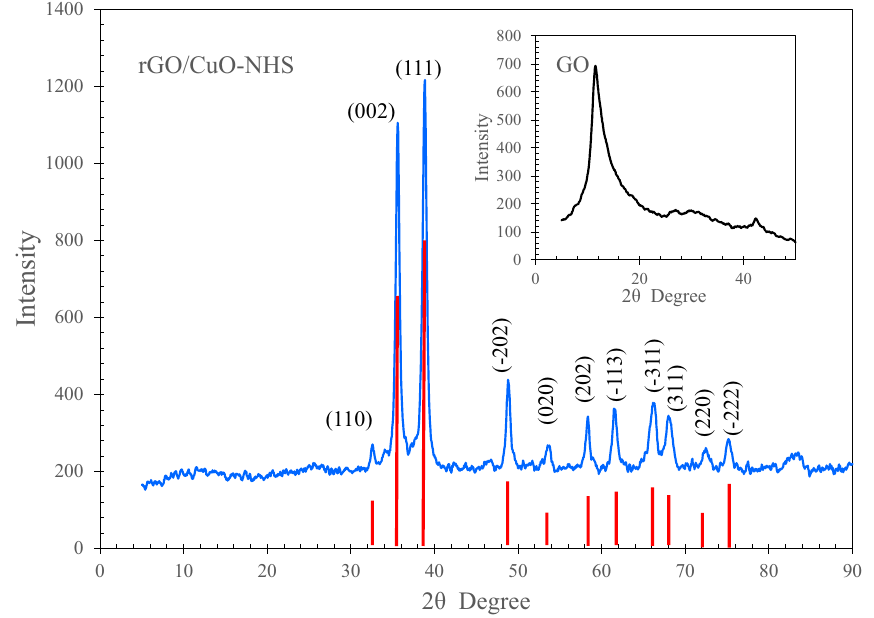
Figure 8. XRD pattern of the synthesized rGO/CuO-NHS. The inset is the XRD of GO.